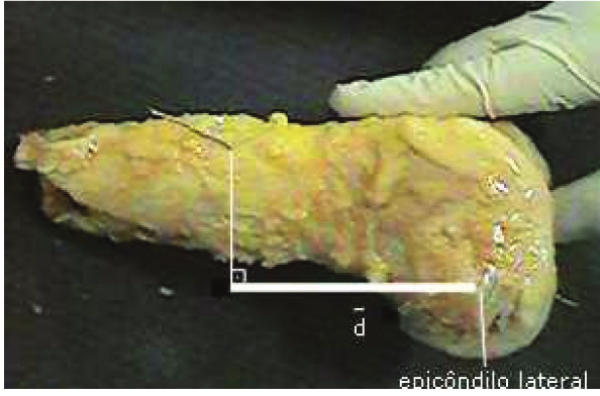
Figure 5 – Distance from the guide exit to the lateral